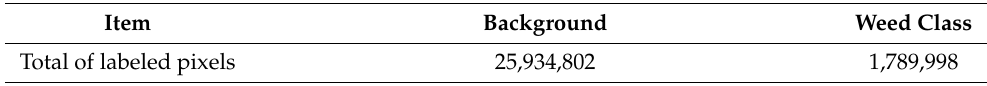
Table 5. Information about the pixels of the weed